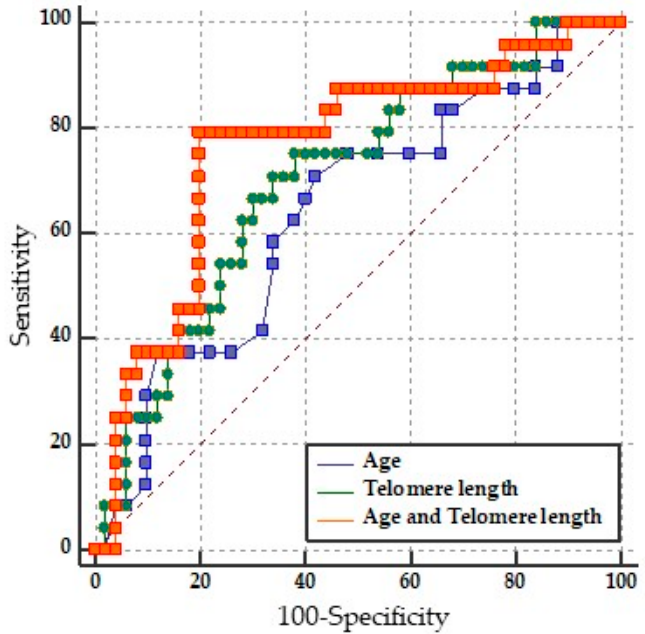
Figure 5. Pairwise comparison of ROC curves of LTL (raw data), age (raw data), and LTL and age (binary logistic regression).